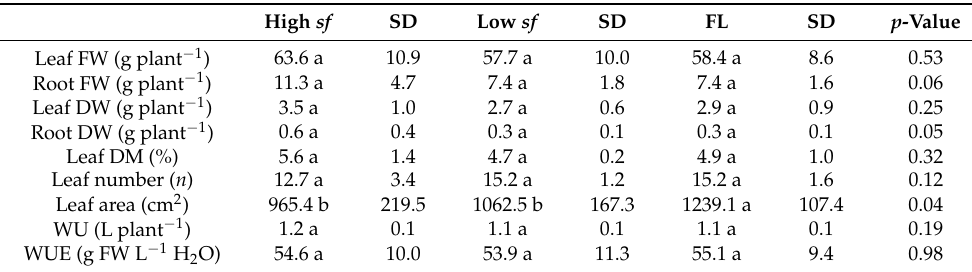
Table 1. Effect of different lighting treatments on morphological parameters, water use, and water use efficiency of indoor-grown lettuce plants ( n = 6). Different letters indicate significant differences at p ≤ 0.05. SD = standard